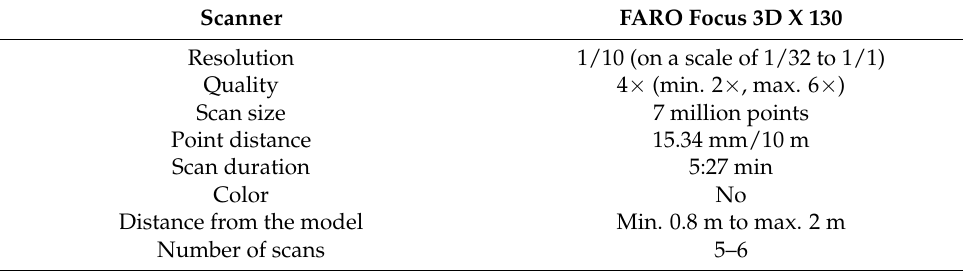
Table 10. Terrestrial laser scanner settings used in the tests.